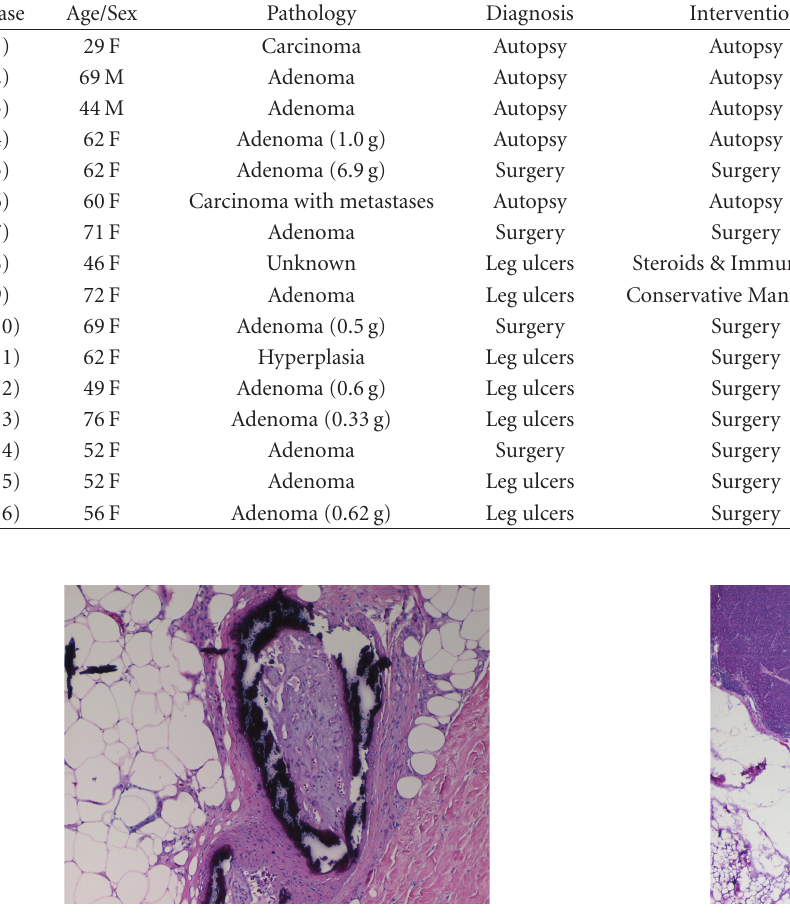
Figure 3: Skin biopsy with demonstration of cutaneous deposition of calcifications in addition to the vascular calcifications.